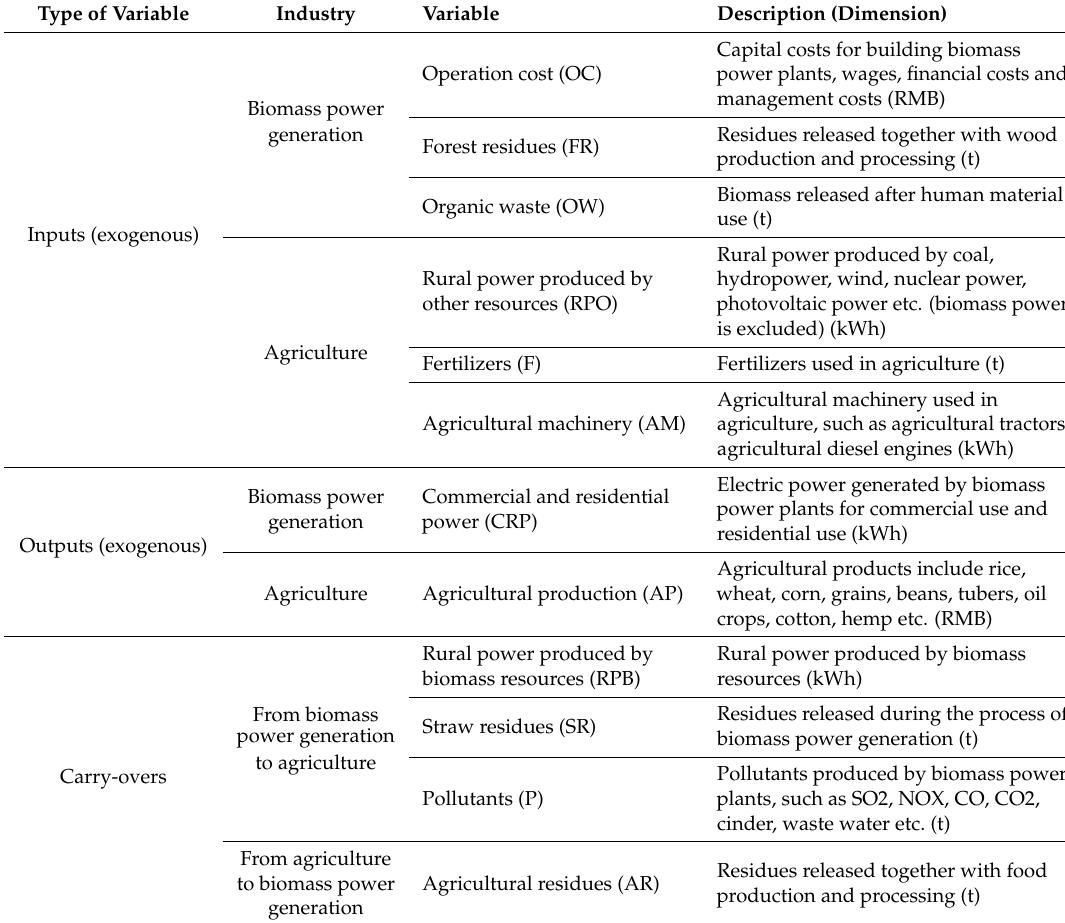
Table 2. Inputs, outputs and carry-overs for the network DEA the